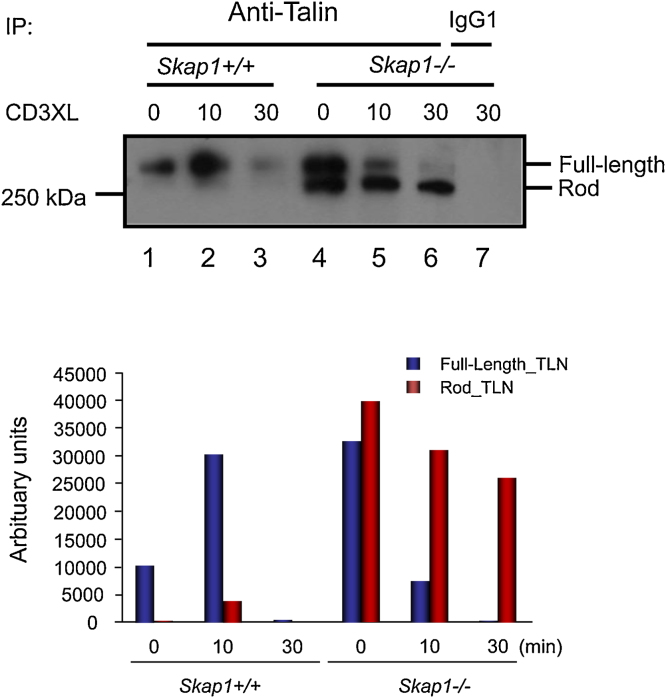
Skap1−/− T-cells show alterations in anti-CD3 induced talin cleavage. (A) Naïve CD3+ T-cells from Skap1+/+ or Skap1−/− mice were activating with cross-linking anti-hamster antibodies alone (0) or with anti-CD3 cross-linked with anti-hamster antibodies for either 10 min (10) or 30 min (30). The cytoplasmic and membrane fractions were isolated as indicated and immunoprecipitated with anti-talin. A negative control sample immunoprecipitated with IgG1 antibodies was included (lane 7). The immunoblots were probed with anti-talin to detect the full length (∼235 kDa) or rod-domain of talin (∼180 kDa). (B) The relative densitometric reading of the full length or rod-domain from lanes 1–6 for the membrane fraction were measured using ImageJ.